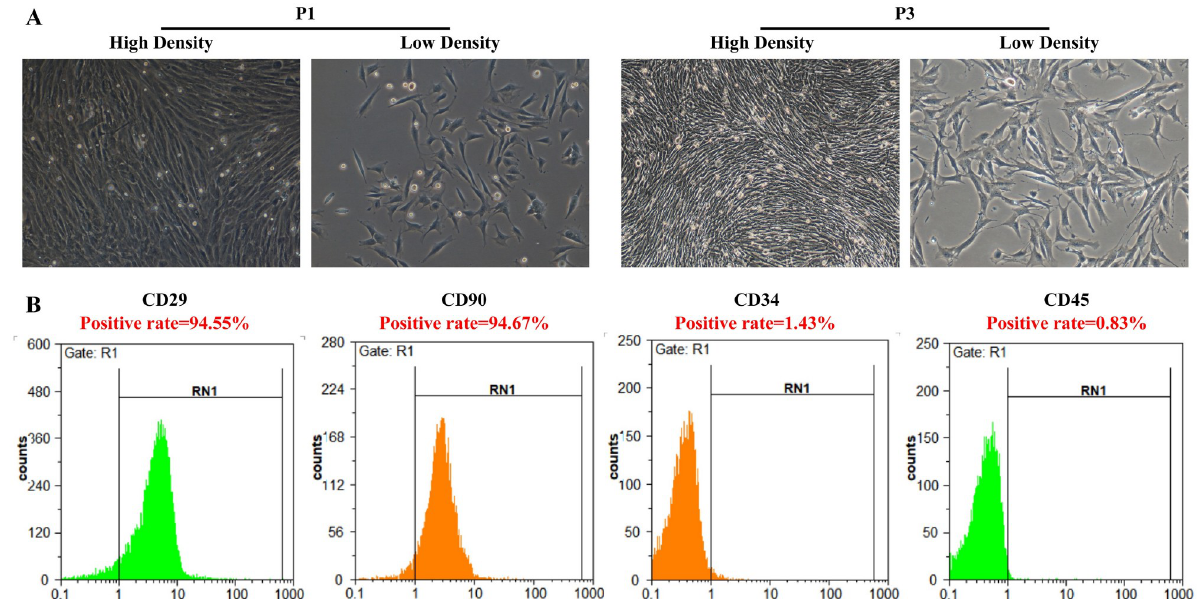
Fig 1. Identification of primary BMSCs. (A) High density and low density of P1 and P3 BMSCs morphology was assessed by an inverted phase contrast microscope. Original magnification: 100 × . (B) CD29, CD34, CD45 and CD90 surface marker expression of BMSCs was determined by flow